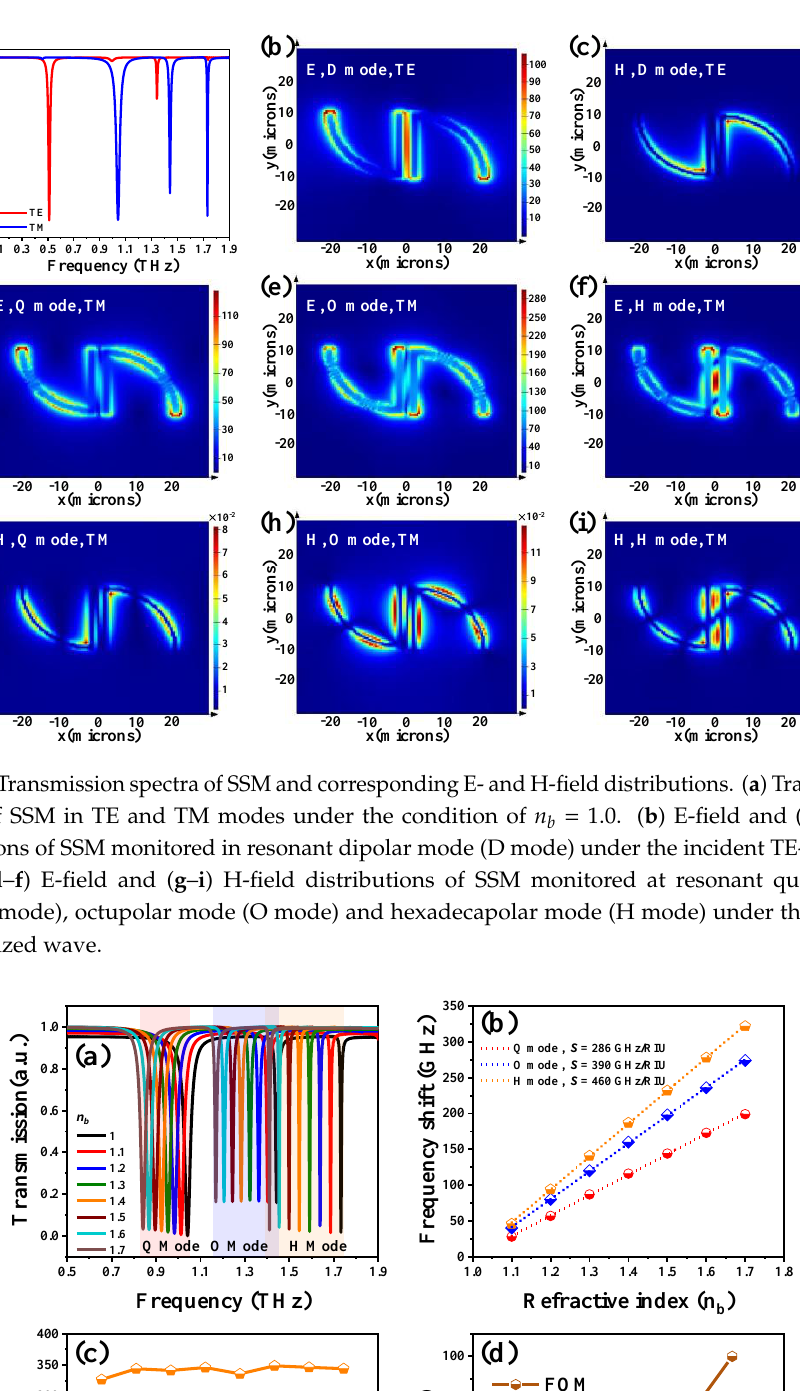
Figure 3. Transmission spectra of SSM and corresponding E- and H-field distributions. ( a ) Transmission spectra of SSM in TE and TM modes under the condition of n b = 1.0. ( b ) E-field and ( c ) H-field distributions of SSM monitored in resonant dipolar mode (D mode) under the incident TE- polarized wave. ( d – f ) E-field and ( g – i ) H-field distributions of SSM monitored at resonant quadrupolar mode (Q mode), octupolar mode (O mode) and hexadecapolar mode (H mode) under the incident TM-polarized wave.